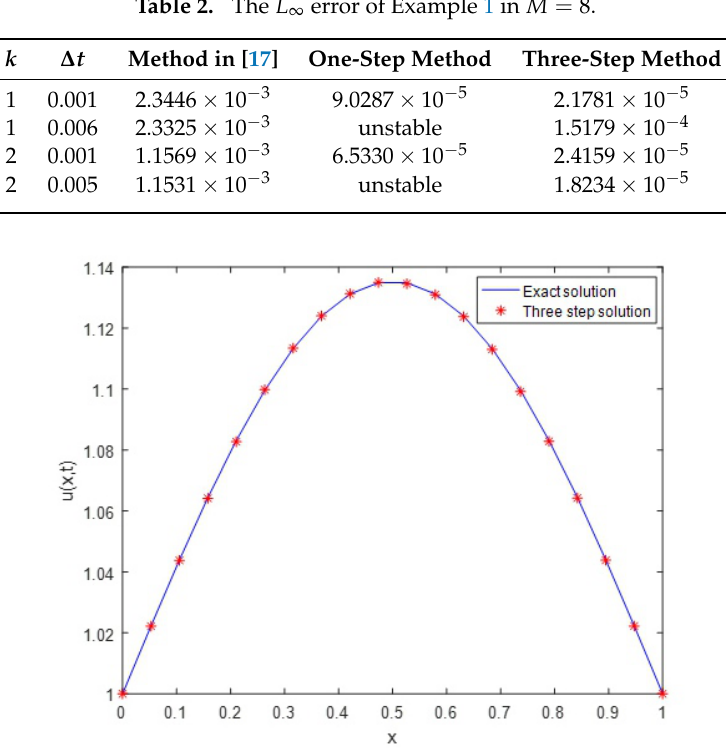
Figure 1. The exact and approximate solutions of Example 1 in the case M = 8, k = 2 and ∆ t =